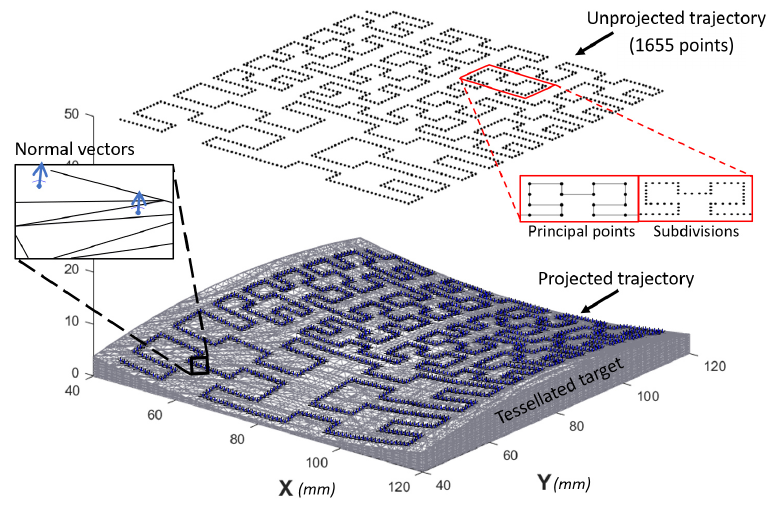
Figure 11. Points of trajectory before and after being mapped on a tessellated surface.